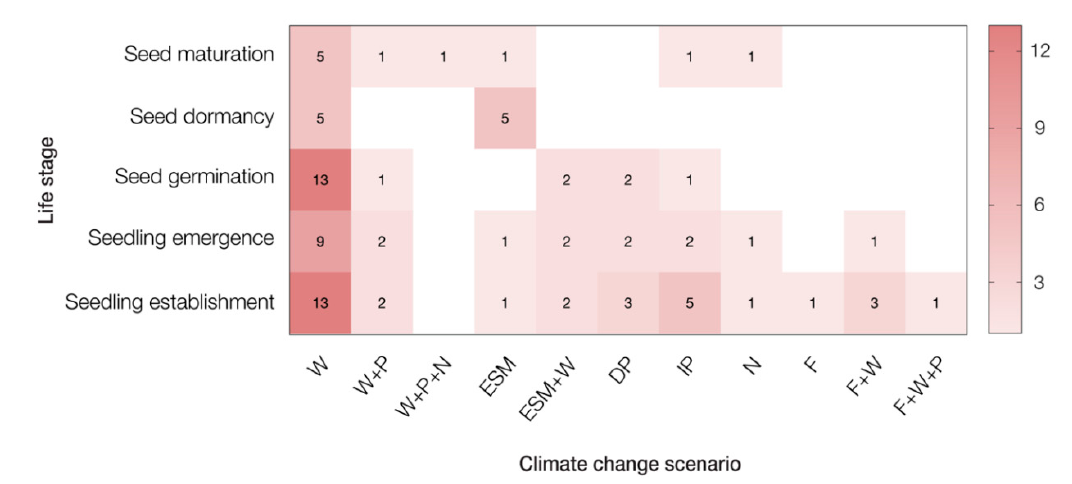
Figure 3. Counts of the number of instances an early life-history stage of plants was studied under a particular climate change scenario. The sum of frequencies could be more than the number of studies included in our review ( n = 39), because more than one life stage or climate change scenario may have been tested in each study. W: warming, W+IP: warming and increase in precipitation, W+IP+N: warming, increase in precipitation and nutrient availability, ESM: early snowmelt, ESM+W: early snowmelt + warming, DP: decrease in precipitation, IP: increase in precipitation, N: nutrient availability, F: post-fire conditions, F+W: post-fire and warming, F+W+P: post-fire, warming and precipitation.